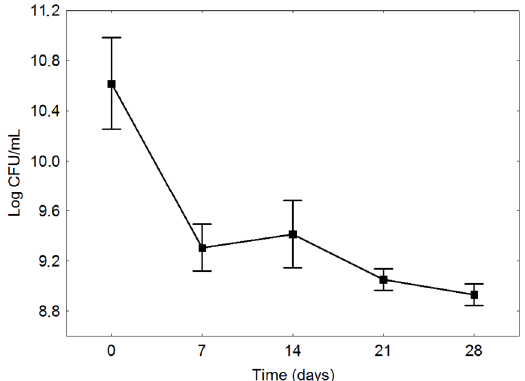
Figure 2. Survival of Lactobacillus reuteri of fermented blueberry and carrot blend during storage for 28 days at 4 °C. The results are shown in the average of three repetitions and standard deviation.